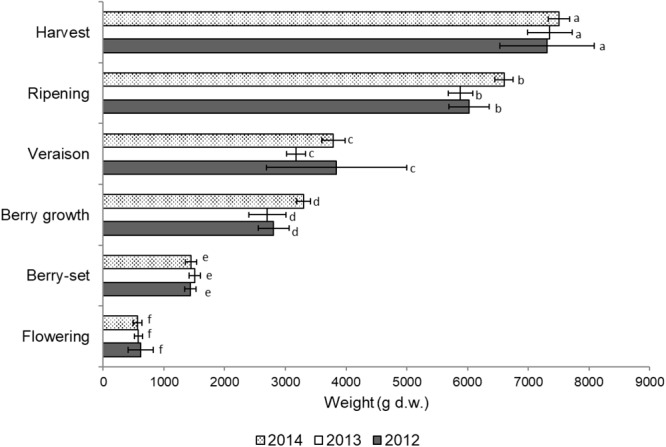
Total vine biomass growth from flowering to harvest (g of dry weight) of Italia table grape throughout the seasons of 2012, 2013, and 2014 as a function of the different phenological growth stages. Bars represent standard deviation. For each season, data points followed by a different letter are significantly different at P ≤ 0.05 according to REGQW test.